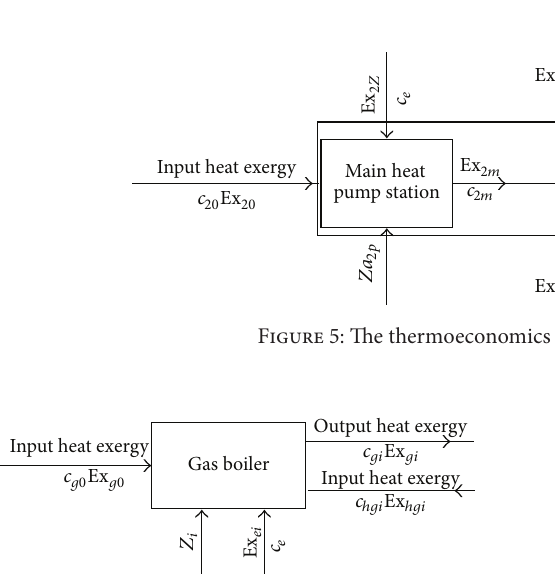
Figure 4: The thermal economics model of distributed heating pump system.